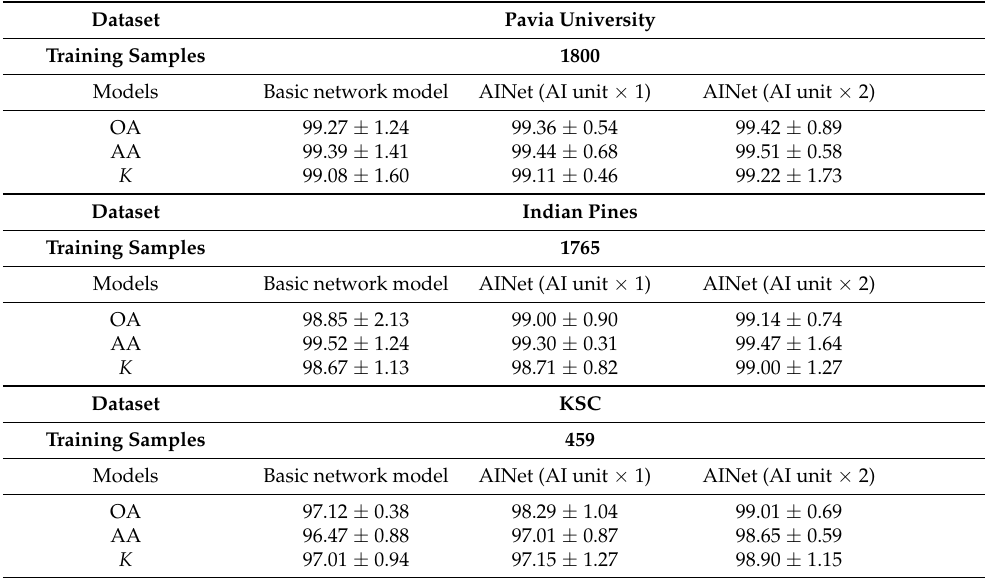
Table 13. Classification results for the three target